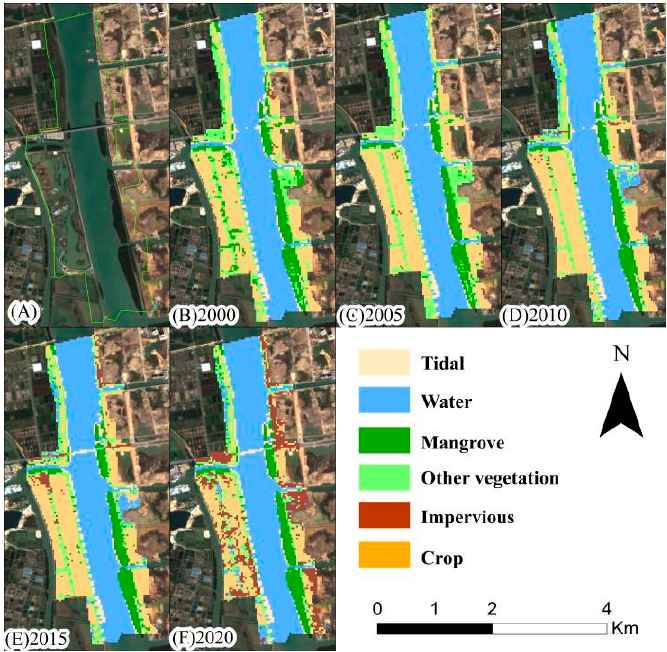
Figure A2. The spatiotemporal changes of mangrove forests in GZCNWP from 2000 to 2020. ( A ): the image of GZCNWP, ( B ): 2000, ( C ): 2005, ( D ): 2010, ( E ): 2015, ( F ): 2020.